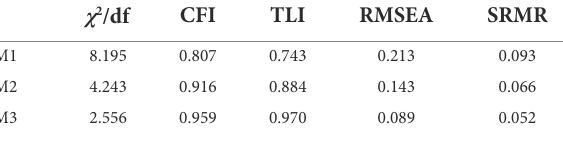
TABLE 5 Fitting indicators for the PETJSS